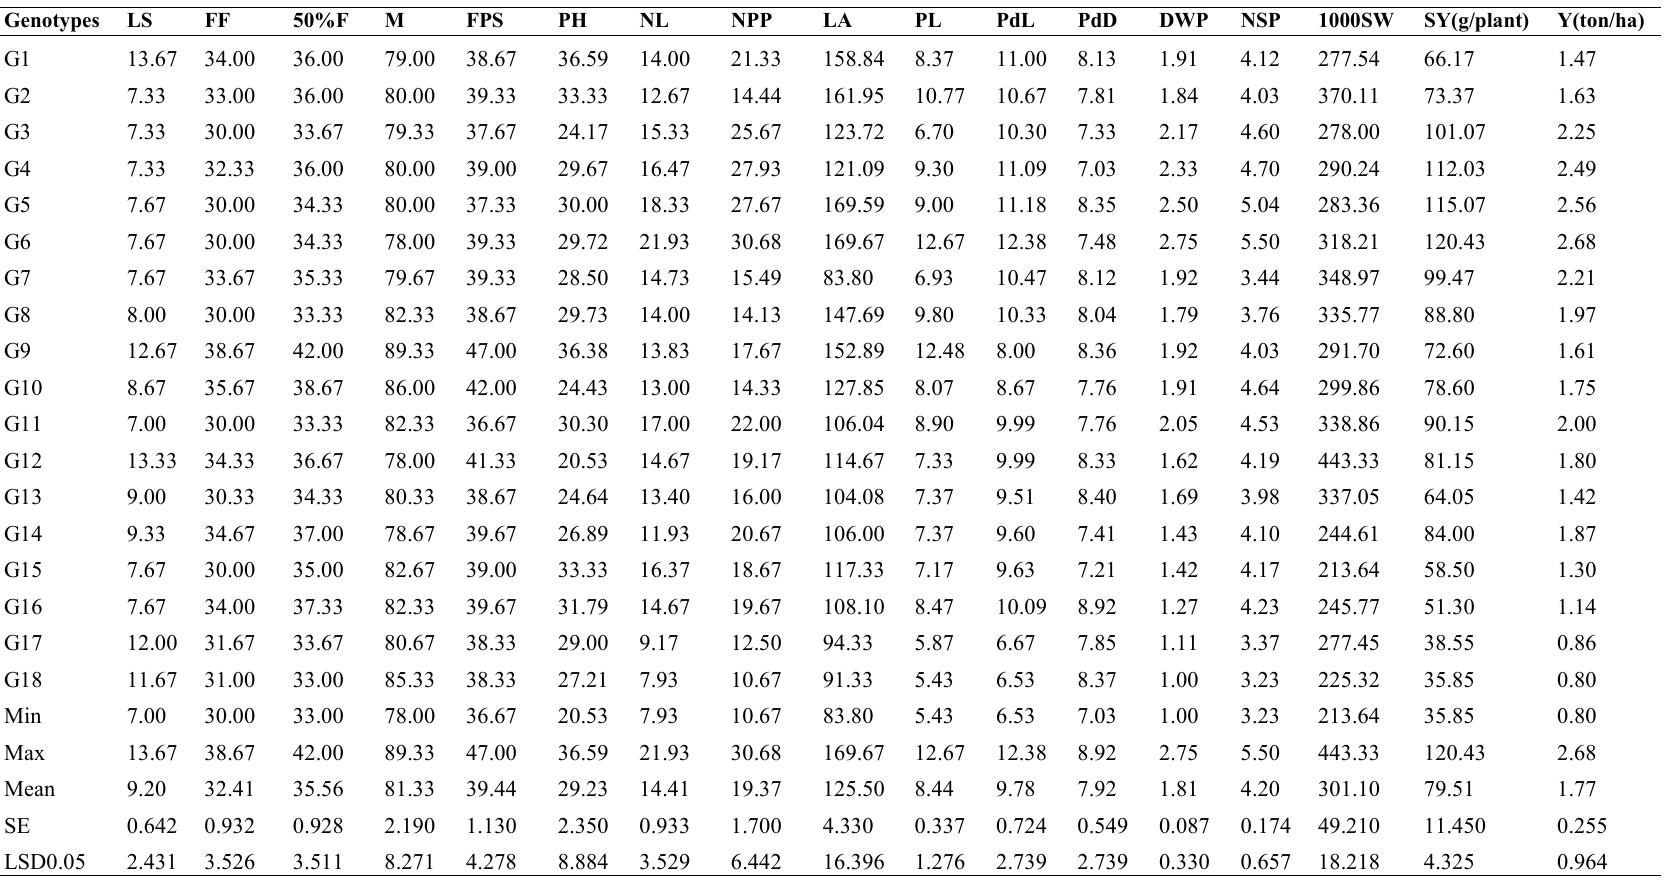
Table 2. Mean (of three replications) performance of various growth parameters and yield components of kidney beans.